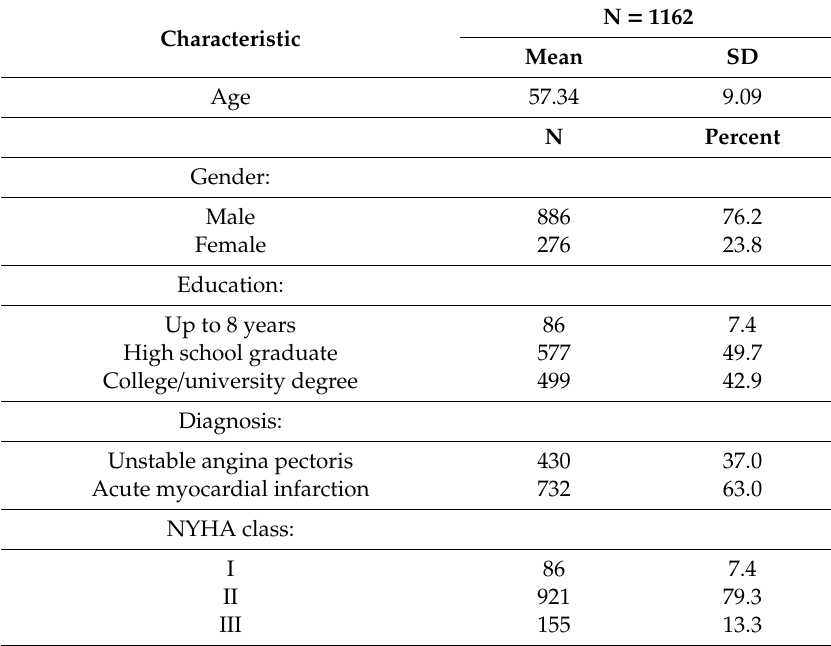
Table 1. Sociodemographic and clinical characteristics of all